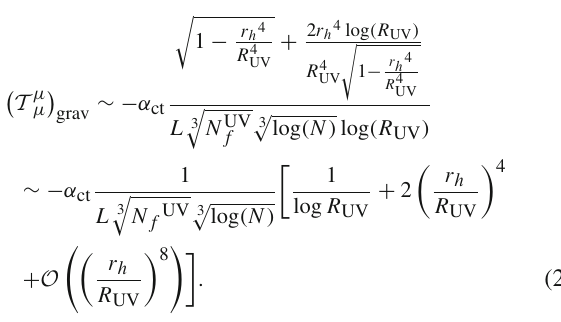
μ μ Fig. 2 The scaled trace anomaly, T , plotted as a function of temper- T 4 ature for the high temperature region. The points represent lattice QCD results (Fig. 2 of Reference [3]). The different N τ values refer to the number of lattice cells in the imaginary time direction. The full curve is the fit obtained with the approach described in 2.1